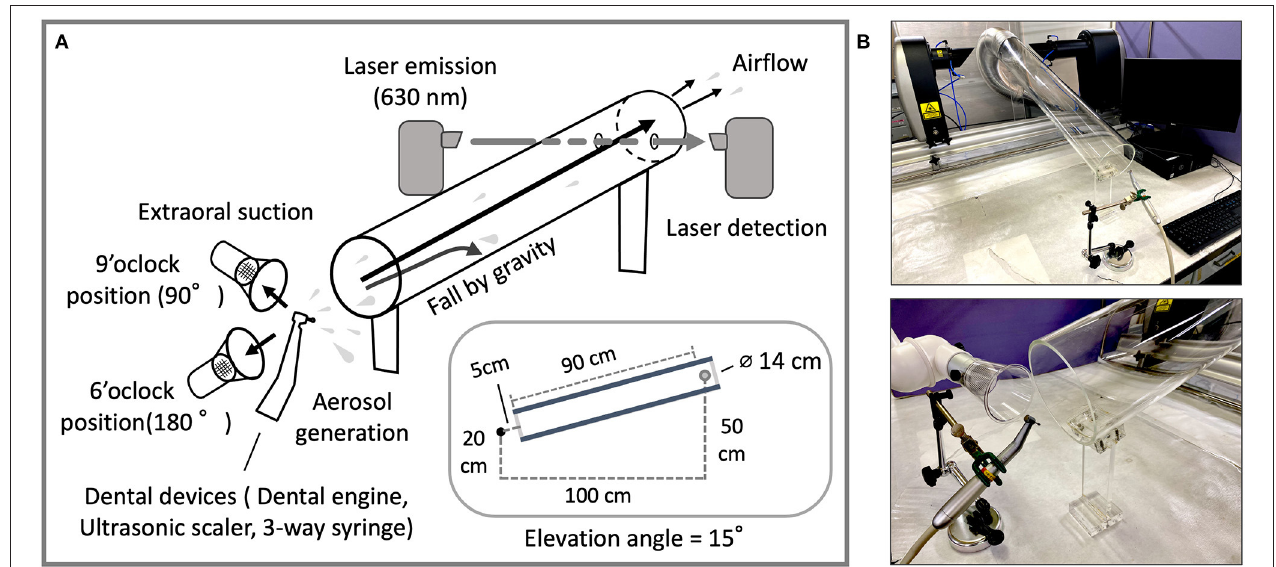
FIGURE 1 | (A) Through-cylinder system; layout and schematic of the cylinder and laser detection device for aerosol measurement. The acrylic cylinder (20cm in diameter and 90cm in length) is set at an angle of 15 degrees. Aerosols from devices were transported by airflow (0.8 m/sec) to the laser position and particle size data was taken at a real-time speed (1Hz) for 25 seconds. (B) The relationship between the position of the aerosol source and the aerosol measurement device. Dental devices were fixed to the column stand (upper). As an example of use, the extraoral suction is placed at the 9 o’clock position to the left of the dental instrument with the direction of aerosol ejection at the 12 o’clock position (lower). The system was covered during measurement to prevent excess airflow from the exterior by a vinyl sheet and the safety